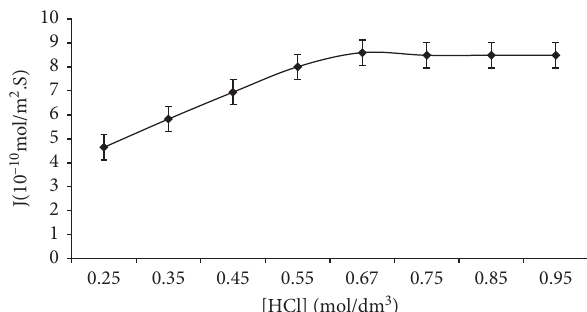
Figure 4: Effect of HCl concentration on transport of As (III). [HCl] in feed solution � 0.25mol/dm 3 to 0.95mol/dm 3 , [TDDA]